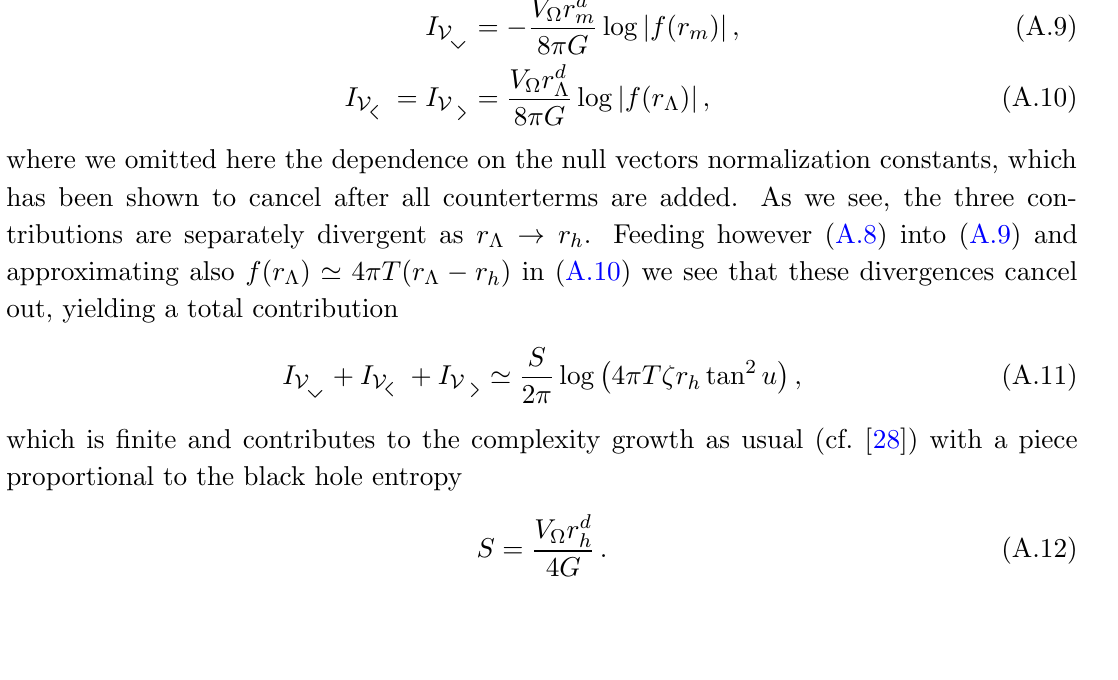
is de(cid:12)ned as the limit C (cid:3) = lim g W u for (cid:12)xed null coordinate u u r (cid:3) ! r h